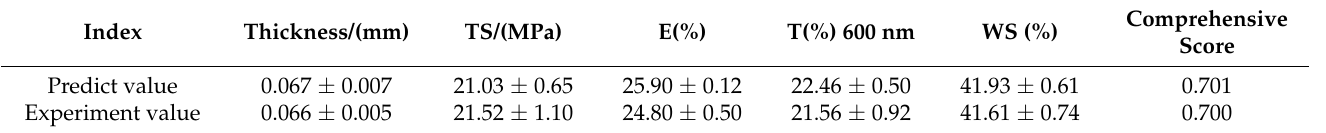
Table 6. Predicted and experimental data for the responses at the optimum